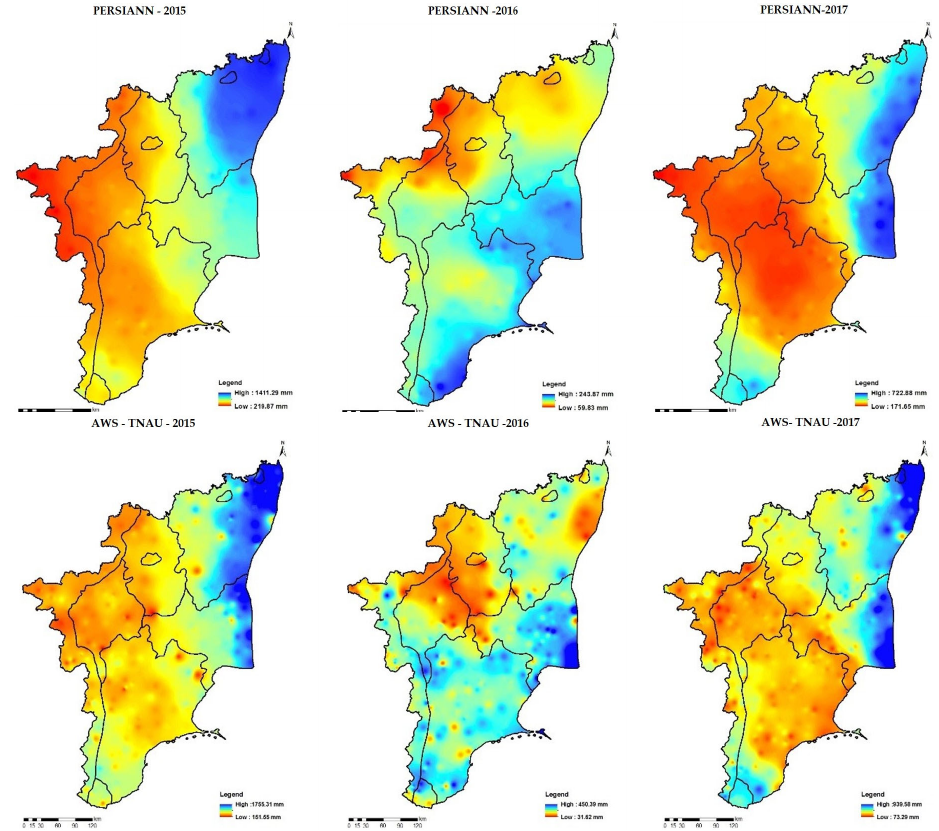
Figure 5. Spatial distribution of accumulated precipitation for IMERGH, TRMM, CHIRPS, PER- SIANN, and AWS-TNAU products during NEM between 2015 and 2017. During 2015, IMERGH, TRMM, CHIRPS, and PERSIANN recorded the maximum values of 1453.63, 1400.07, 1563.72, and 1411.29 mm of precipitation, respectively, as against 1755.31 mm recorded with AWS. Minimum precipitation of 149.5, 144.31, 296.34, and 219.87 mm was recorded with the respective high-resolution precipitation products, and AWS recorded 151.65 mm precipitation, contrary to the precipitation products. IMERGH, TRMM, CHIRPS, and PERSIANN recorded the maximum values of 253.40, 250.98, 421.12, and 243.87 mm of precipitation, respectively, during 2016, as against 450.39 mm recorded with AWS. Minimum values of 32.07, 34.40, 95.24, and 59.83 mm of accu- mulated precipitation were recorded with the corresponding satellite precipitation prod- uct in contrast with AWS, which recorded 31.82 mm of precipitation. During 2017, the maximum precipitation values of 700.59, 686.95, 722.88, and 722.88 mm were recorded with IMERGH, TRMM, CHIRPS, and PERSIANN, respectively, when compared with 939.58 mm precipitation recorded in AWS. Minimum precipitation of 80.05, 75.01, 171.65,